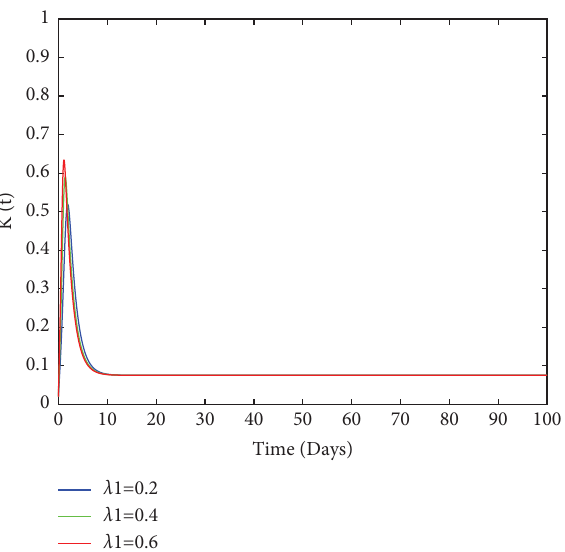
Figure 8: Te density of knower individuals changes with the value of λ